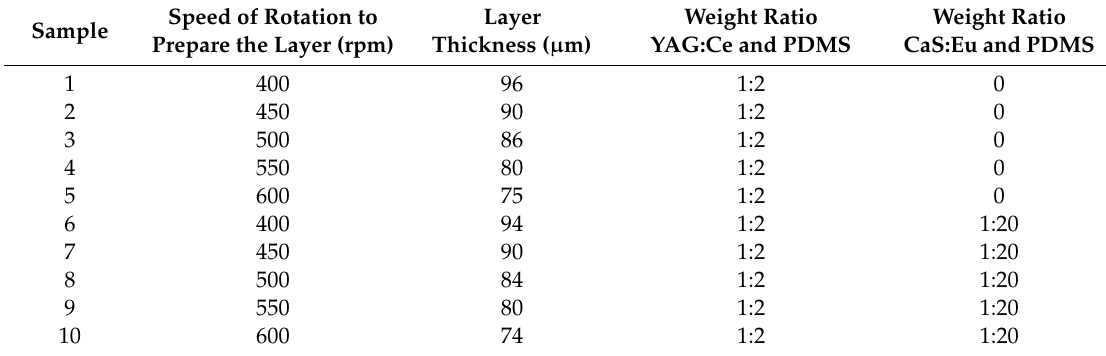
Table 1. Characteristics of prepared samples 1–10.